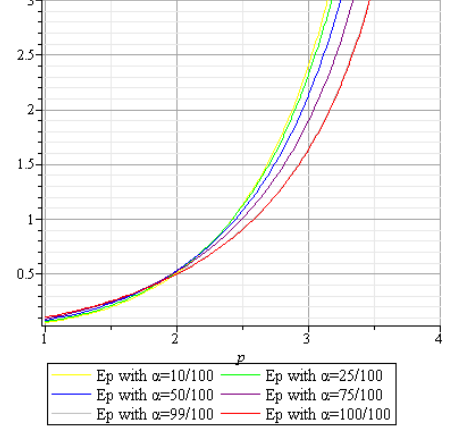
Fig. 1. Curve of 𝐸 ( 𝑝 ) with 𝛼 = 1, (cid:2877)(cid:2877)